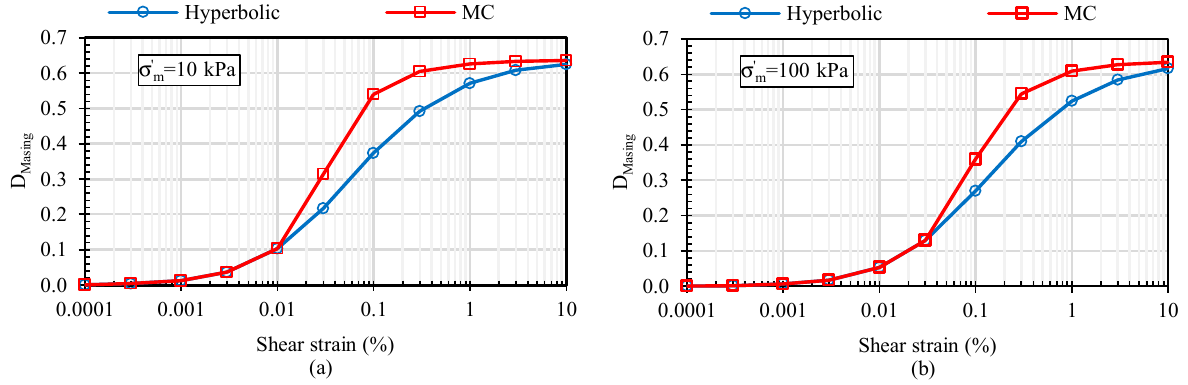
Figure 3. The comparison of Masing damping ratio curves for hyperbolic and MC models for ( a ) σ ’ m = 10 kPa and ( b ) σ ’ m = 100 kPa.